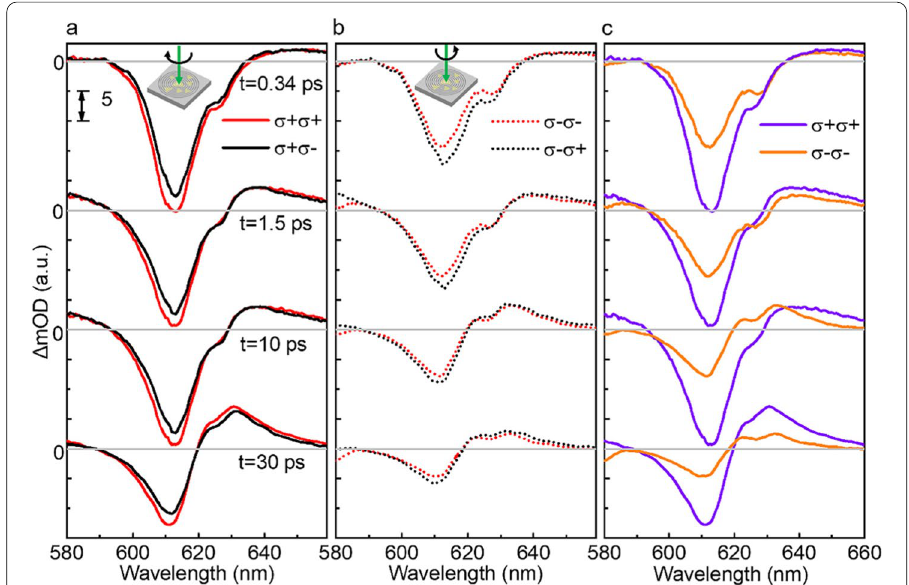
Fig. 8 Circular polarized TA spectra of WS 2 ‑spiral Ag grating devices. a , b Circular polarized TA spectra of WS 2 ‑spiral Ag grating devices with a 400 nm period at different delay times (0.34 ps, 1.5 ps, 10 ps, 30 ps) under the σ ( a ) and σ‑ ( b ) excitation. c The σ σ and σ‑σ‑ TA spectra at different delay times are extracted and + + + compared. The excitation wavelength is 560